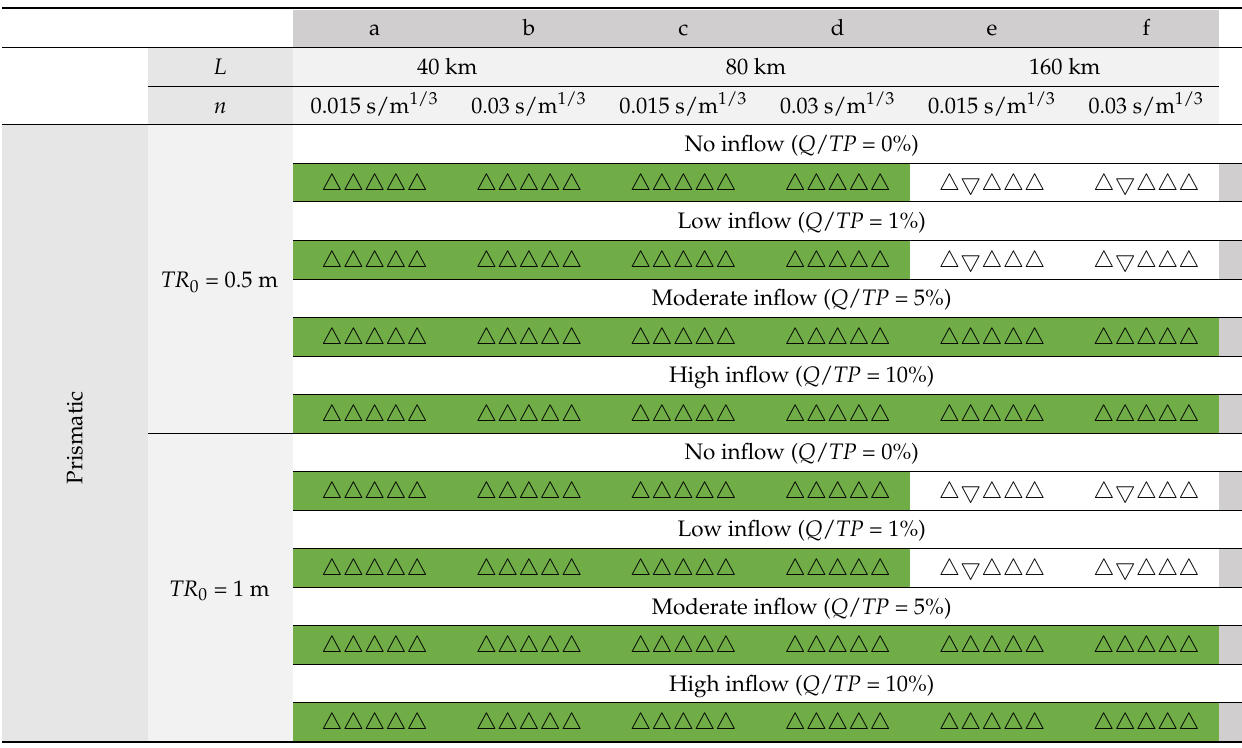
Table 1. Compounding effects of SLR and varying river inflows on tidal range at five nodes along the estuaries ( x = 0, 0.25 L , 0.5 L , 0.75 L , and L ), which are represented by five consecutive triangles in each cell. Upward and downward triangles indicate an increase or a decrease in tidal range induced by 1 m of SLR and for four varying river inflows ( Q / TP = 0%, 1%, 5%, and 10%). Hollow and solid triangles imply weak (0 ≤ | α | ≤ 0.5) and strong (0.5 < | α | ≤ 1) Pearson correlation coefficients, respectively. The symbol “–” denotes the absence of a correlation (for details, see [46]). Dominant patterns of change in tidal properties under compounding effects of SLR and river inflows are highlighted with similar colours across Tables